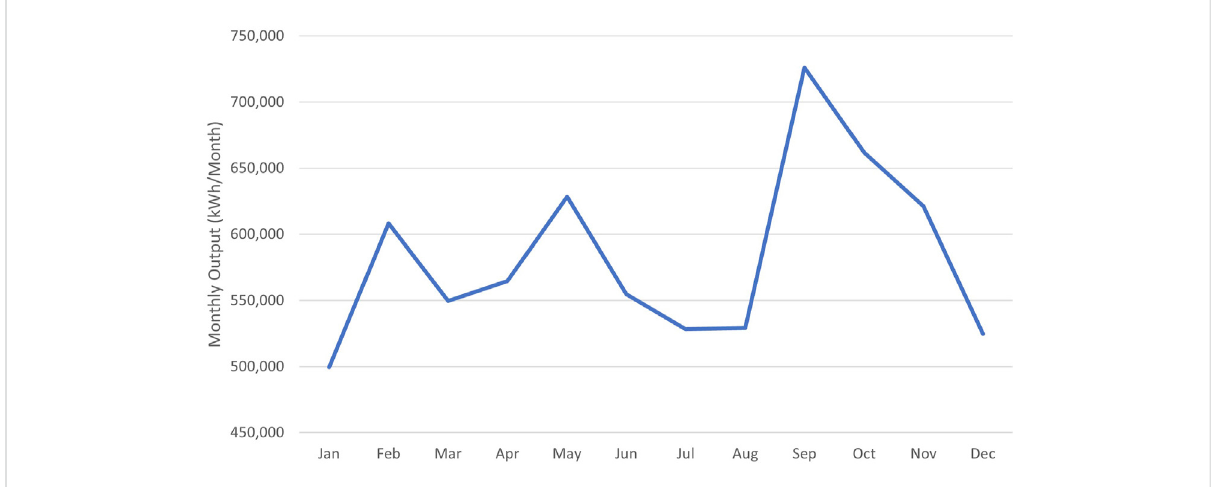
Figure 3, showing a cut-in wind speed of about 4.0 m/s and a cut-out wind speed of 20.0